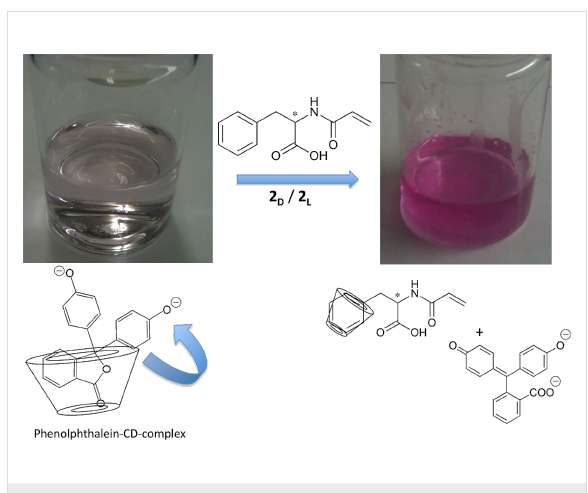
Figure 5: Complex formation with phenolphthalein and phenylalanine as